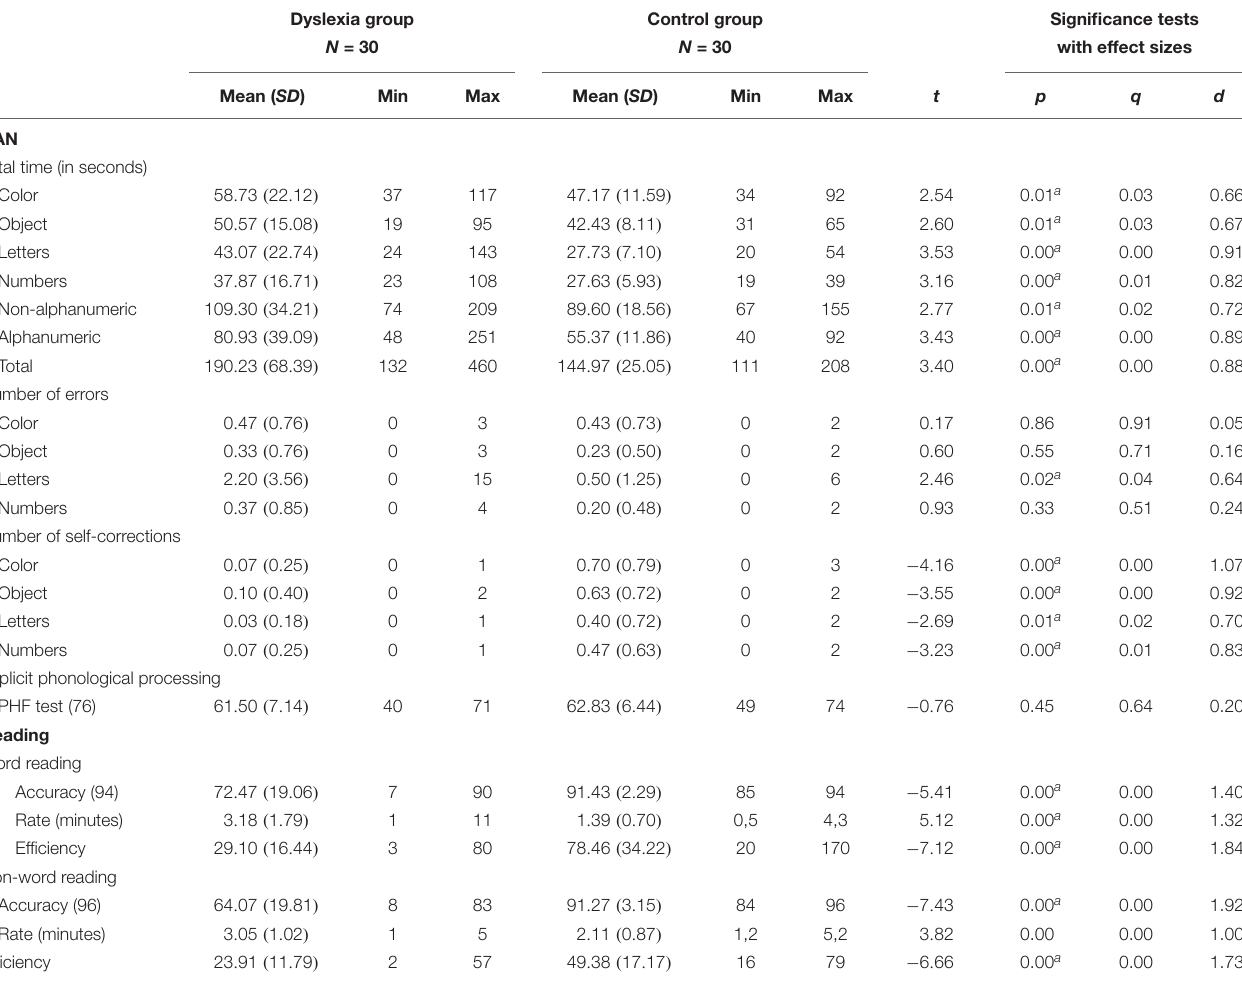
TABLE 2 | Mean raw scores ( SD ) with minimum and maximum scores on RAN, explicit phonological processing, and reading measures according to group, with significance tests and effect sizes. Dyslexia group Control